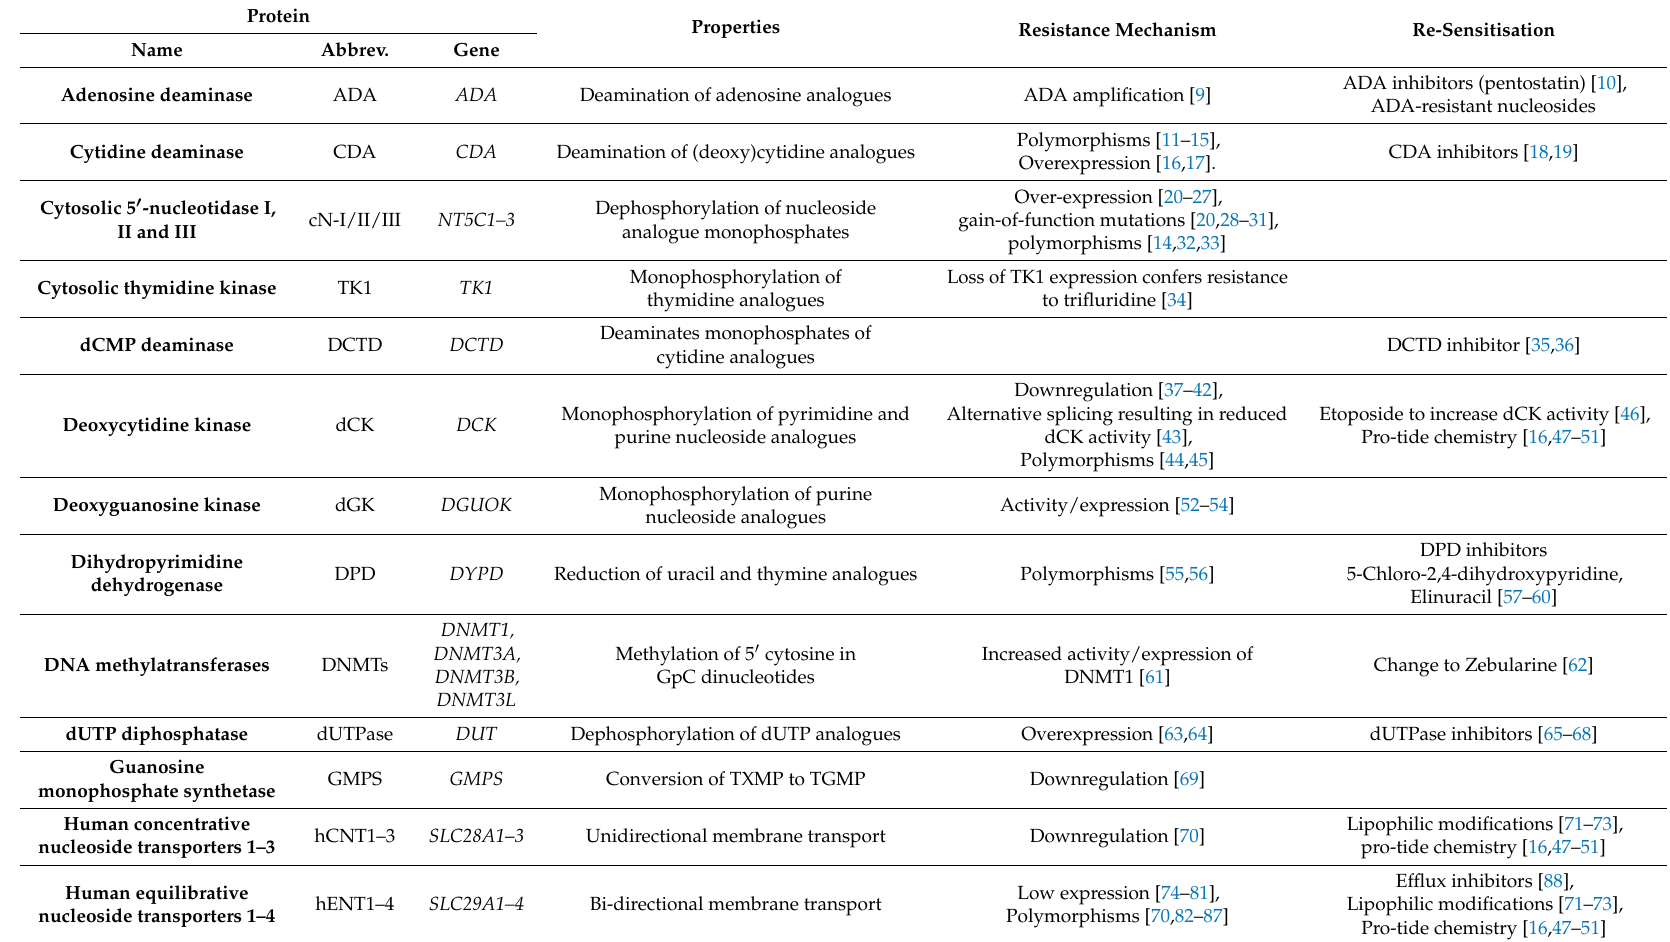
Table 1. Overview on pharmacokinetic and pharmacodynamic factors for nucleobase/nucleoside analogues, resistance mechanisms, and strategies of